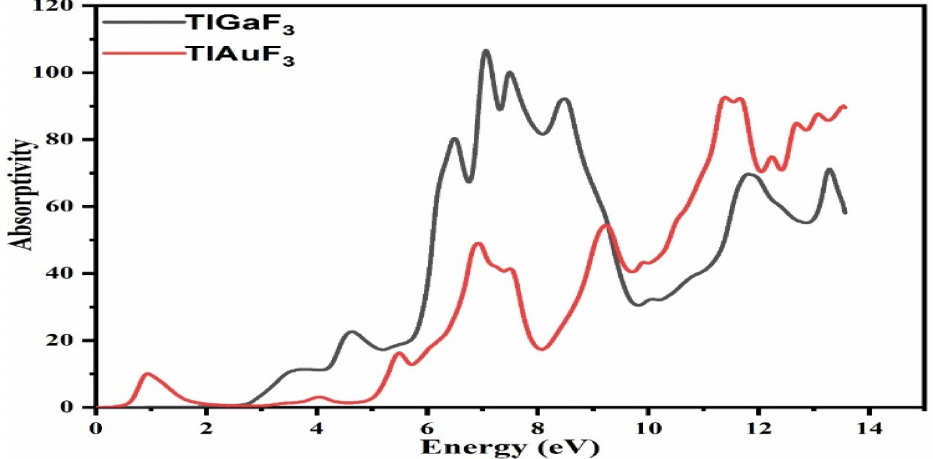
Figure 7. Representation of the absorptivity of fluoro-perovskite TlMF 3 (M= Au, Ga) vs. response to incident